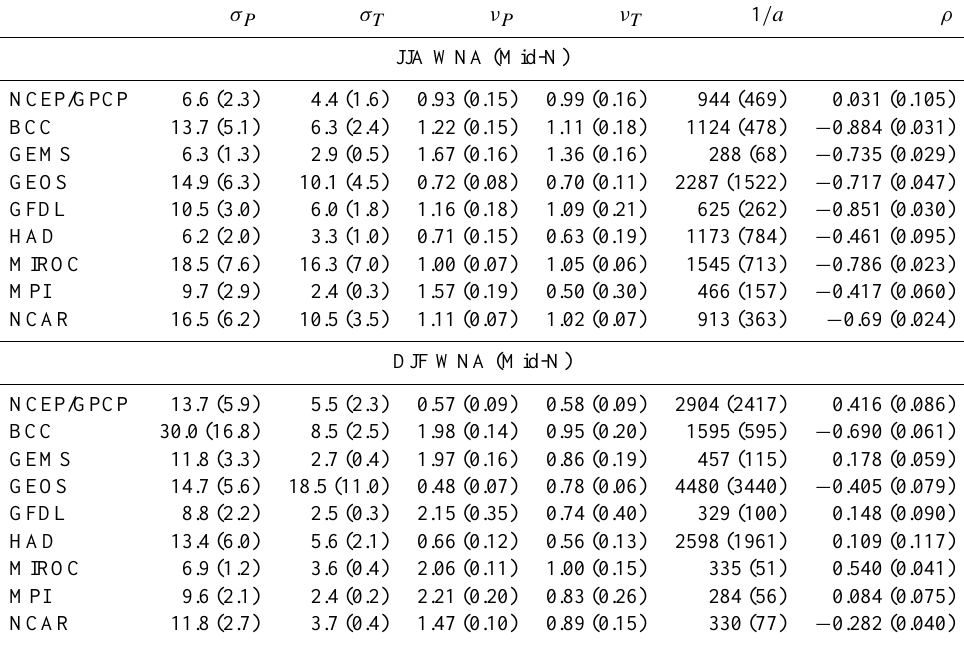
Table 3. Sample region (WNA) parameter point estimate (asymptotic standard error)